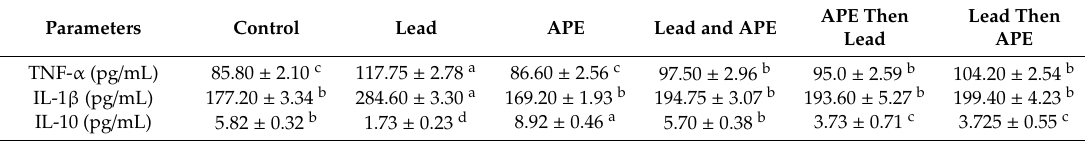
Table 4. The e ff ects of lead and / or Azolla pinnata ethanolic extract (APE) on serum levels of